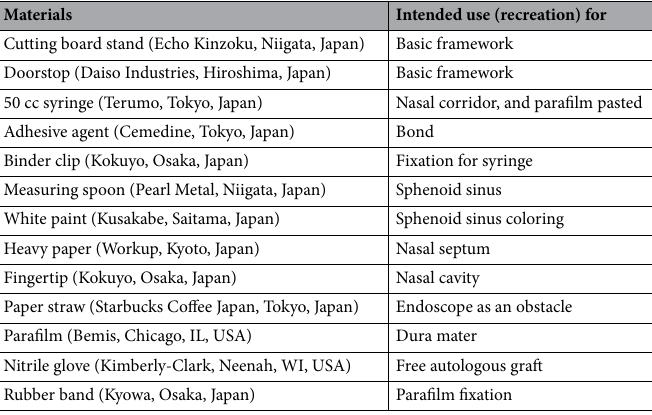
Table 1. Materials and use